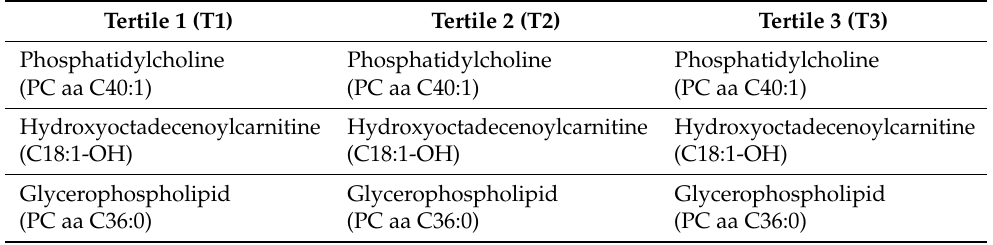
Table 3. The top three fecal metabolites selected for each of the machine learning analyses.